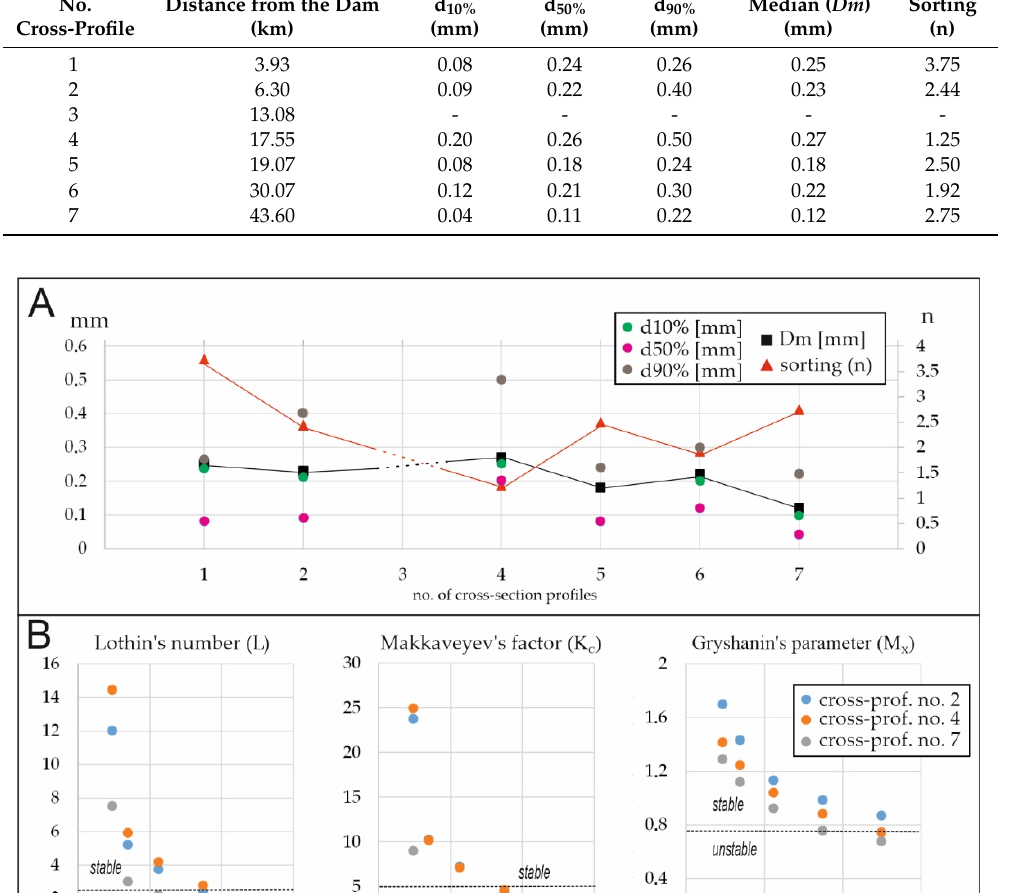
Table 4. Morphological indicators * of the Dnieper channel stability downstream of the Kaniv HPP during different water discharge conditions and related hydraulic gradients.